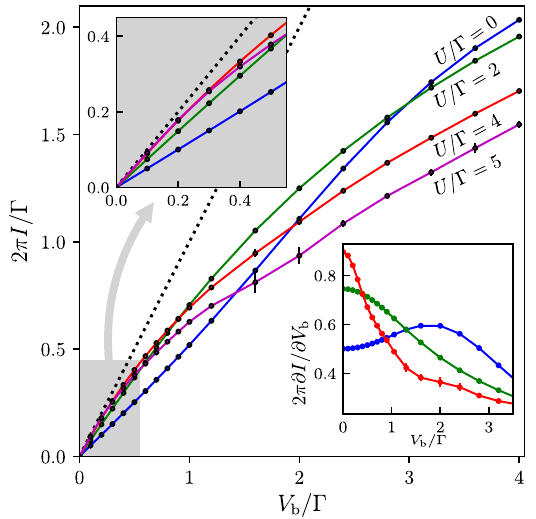
FIG. 16. Current-voltage characteristics at different interaction = Γ ¼ 1 ). The bottom-right strengths in the asymmetric model ( ϵ d inset shows the development of the zero-bias anomaly in the differential conductance when U increases ( U= Γ ¼ 0 in blue, 2 in green, and 4 in